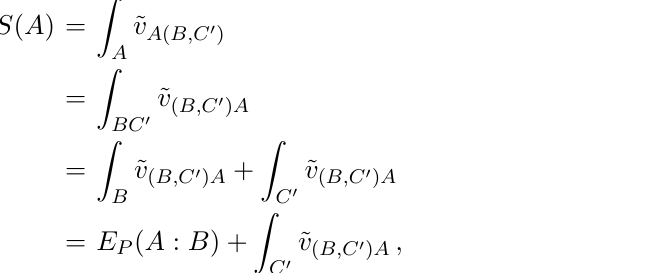
Figure 5 . Left: the vector (cid:12)eld ~ v , a (cid:13)ow that simultaneously maximizes the (cid:13)ux A ! (cid:22) A A ( B;C 0 ) (bounded above by the area of m A ) and the (cid:13)ux A ! B (bounded above by the area of (cid:27) min It allows us to compute S ( A ) and E P ( A : B ) simultaneously. Right: similarly, the vector (cid:12)eld ~ v , a (cid:13)ow that simultaneously maximizes the (cid:13)ux B ! (cid:22) B (bounded above by the area of m B ) B ( A;C 0 ) and the (cid:13)ux B ! A (bounded above by the area of (cid:27) min ). So we can compute S ( B ) and E P ( A : B ) AB